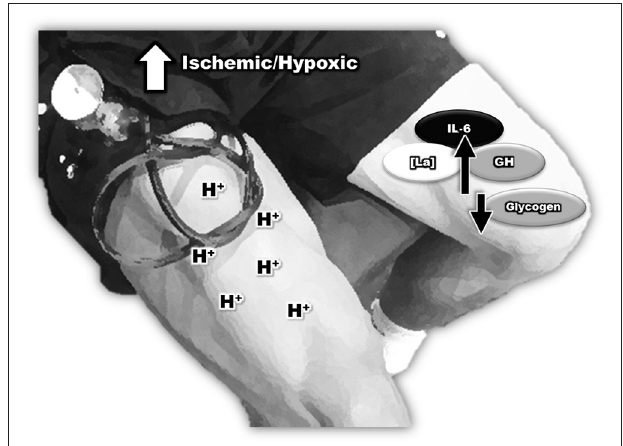
FIGURE 2 | The inflammatory response during blood flow restriction plus low-intensity strength